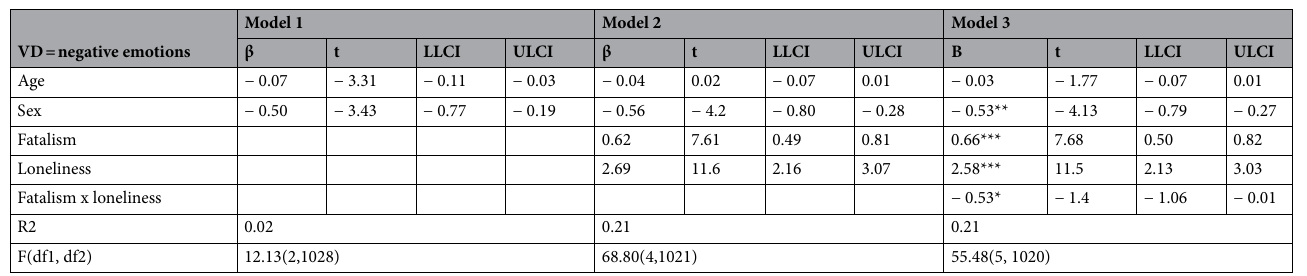
Table 5. Linear regression and Hayes’ linear regression analyses considering loneliness a moderator (Dependent variable: negative emotions).